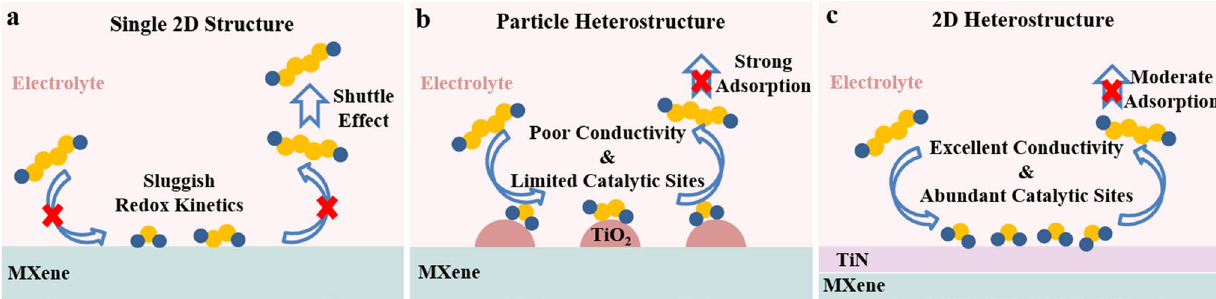
Fig. 5 Schematic illustration of adsorptive and catalytic mechanism of LiPSs species by different structures of a pure MXene, b MX‑TiO 2 ,